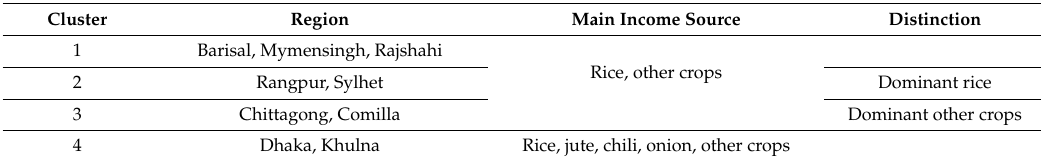
Figure 3. Dendrogram showing clusters for agricultural income sources, by region. Table 5. Cluster characteristics of agricultural income sources, by